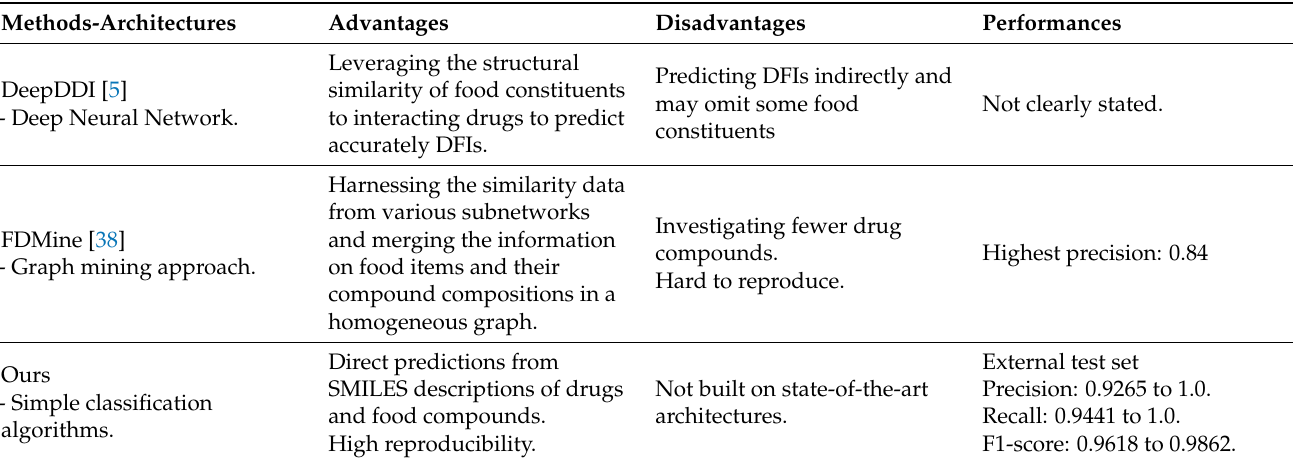
Table 6. Comparison of previous methods and ours in terms of advantages, disadvantages, and main